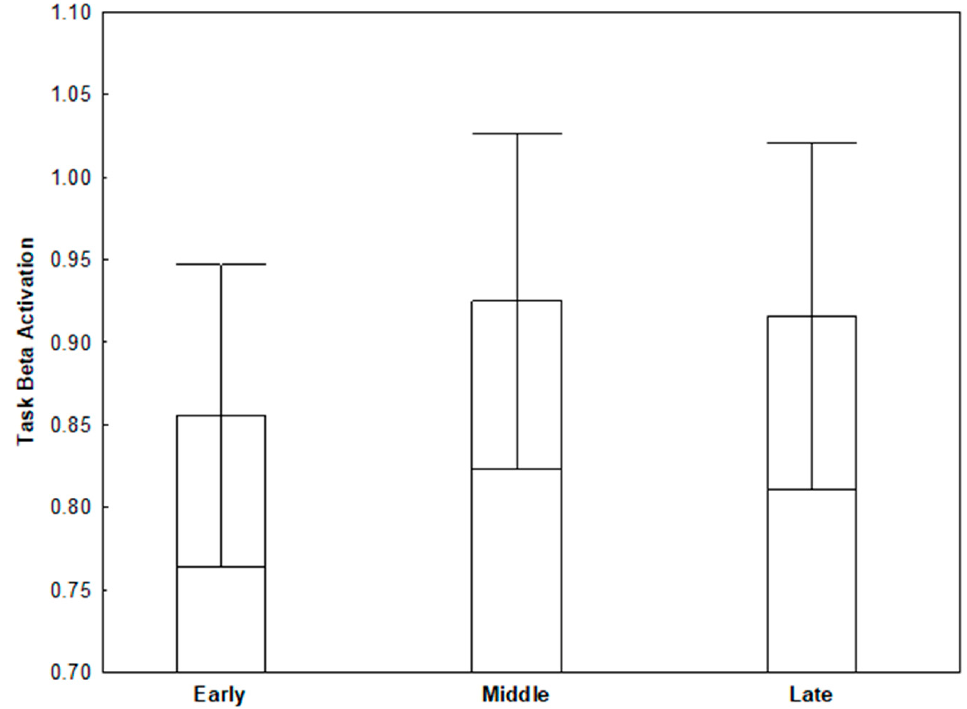
Figure 3. Task beta activation during hard trials depicting decreased beta activation for the early segment of the hard trials relative to the middle and late segments. Error bars indicate standard errors from the mean.